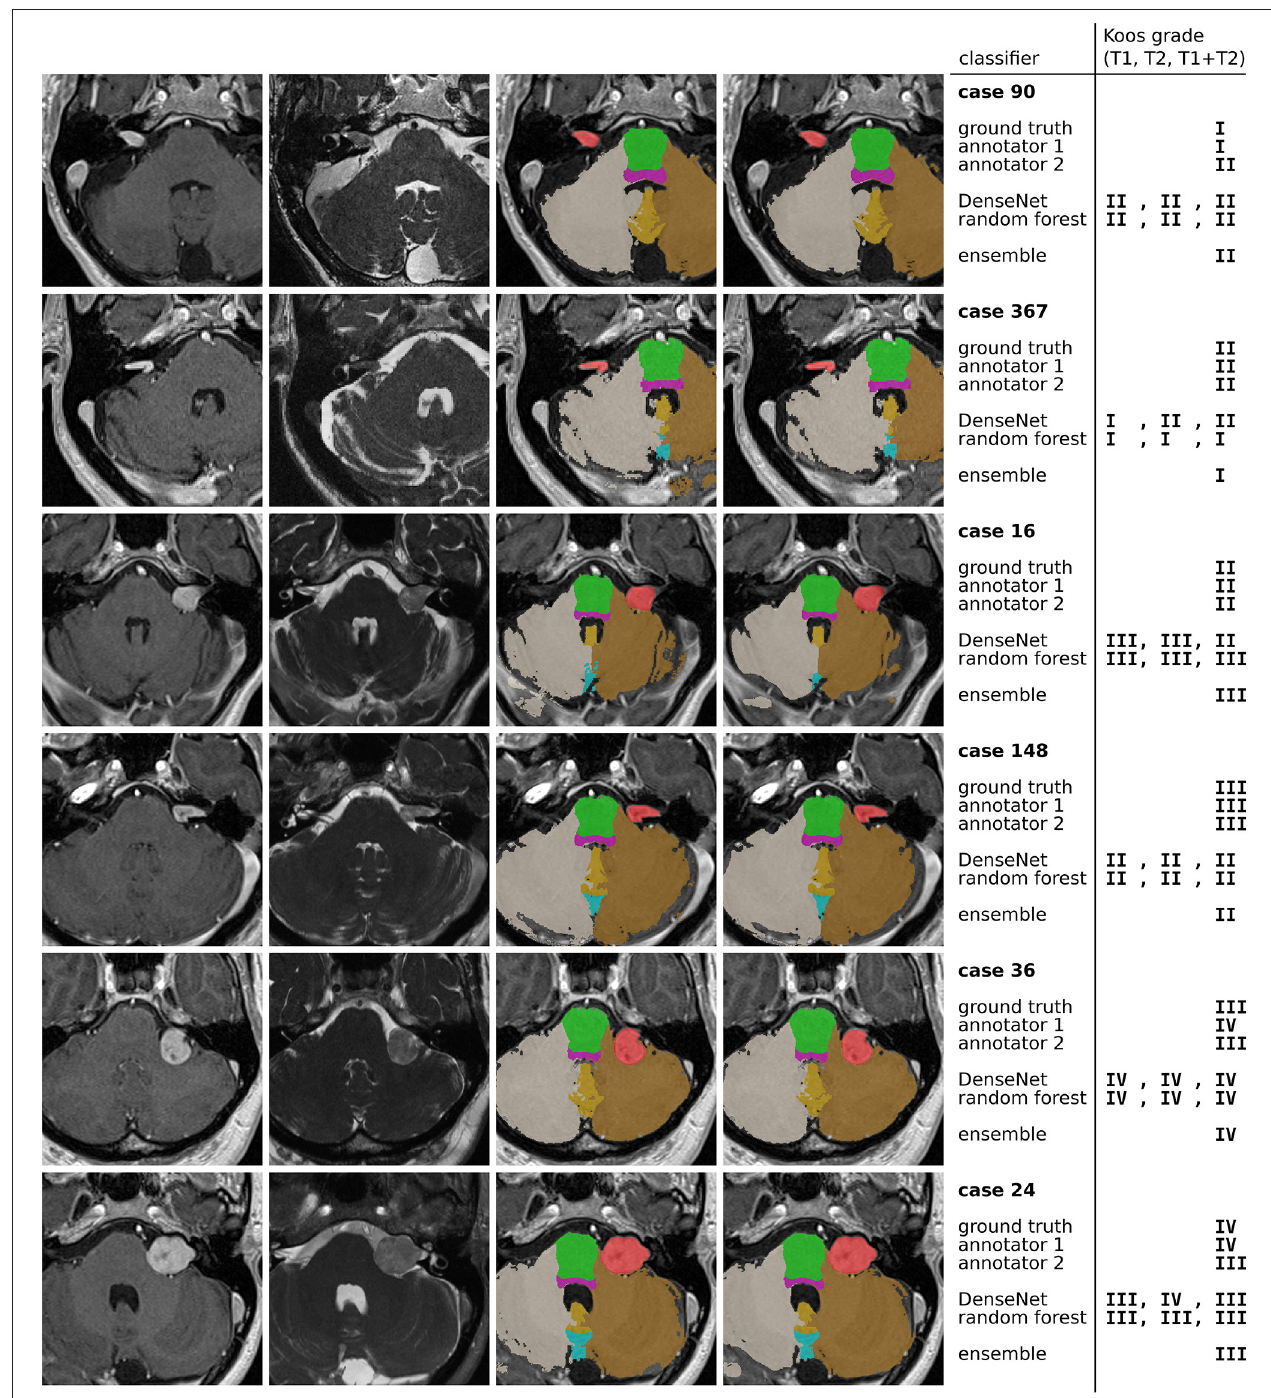
FIGURE 5 | Examples of misclassified cases. The 4 columns contain ceT1 images, hrT2 images, ground truth segmentations resulting from GIF, and predicted segmentations by the nnU-Net model. The colors indicate the segmentation labels of VS (red), pons (green), brain stem (purple), left cerebellum (brown), right cerebellum (gray), cerebellar vermal lobules I-V (yellow) and VI-VII (light